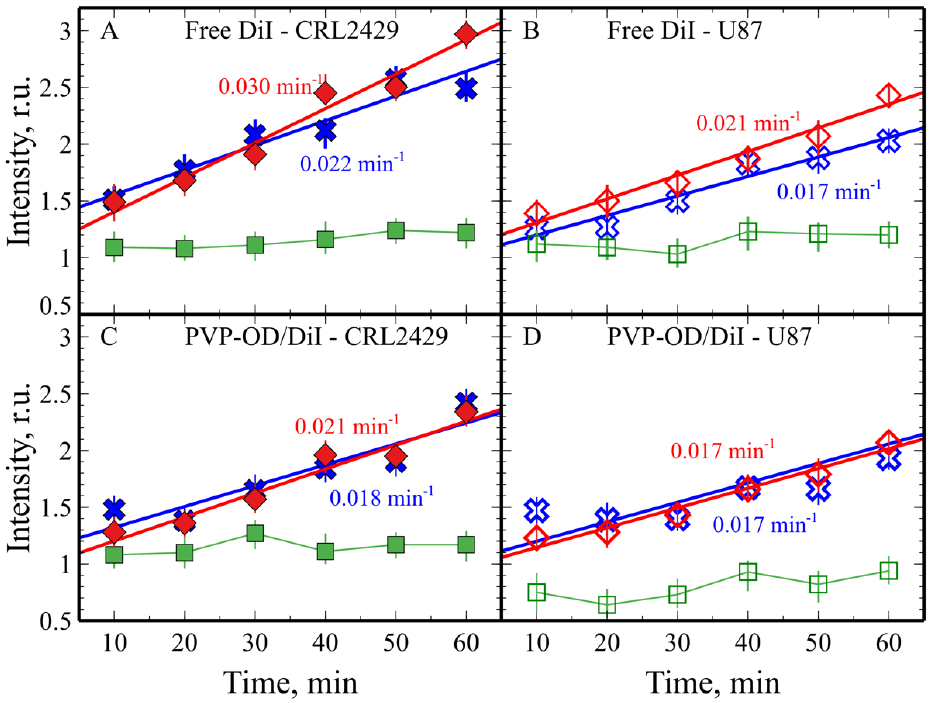
Figure 7. Uptake kinetics of free DiI ( A , B ) and DiI-loaded PVP-OD nanoparticles ( C , D ) for CRL 2429 fibroblasts ( A , C ) and U87 glioblastoma ( B , D ) cell lines and in the absence of endocytosis inhibitors (red), in the presence of wortmannin (blue) and dynasore (green) measured as the dependence of relative DiI fluorescence on the incubation time. Trend lines and the respective rate coefficients for the uptake without inhibitors, in the presence of wortmannin and in the presence of dynasore are shown in red, blue, and green, respectively.